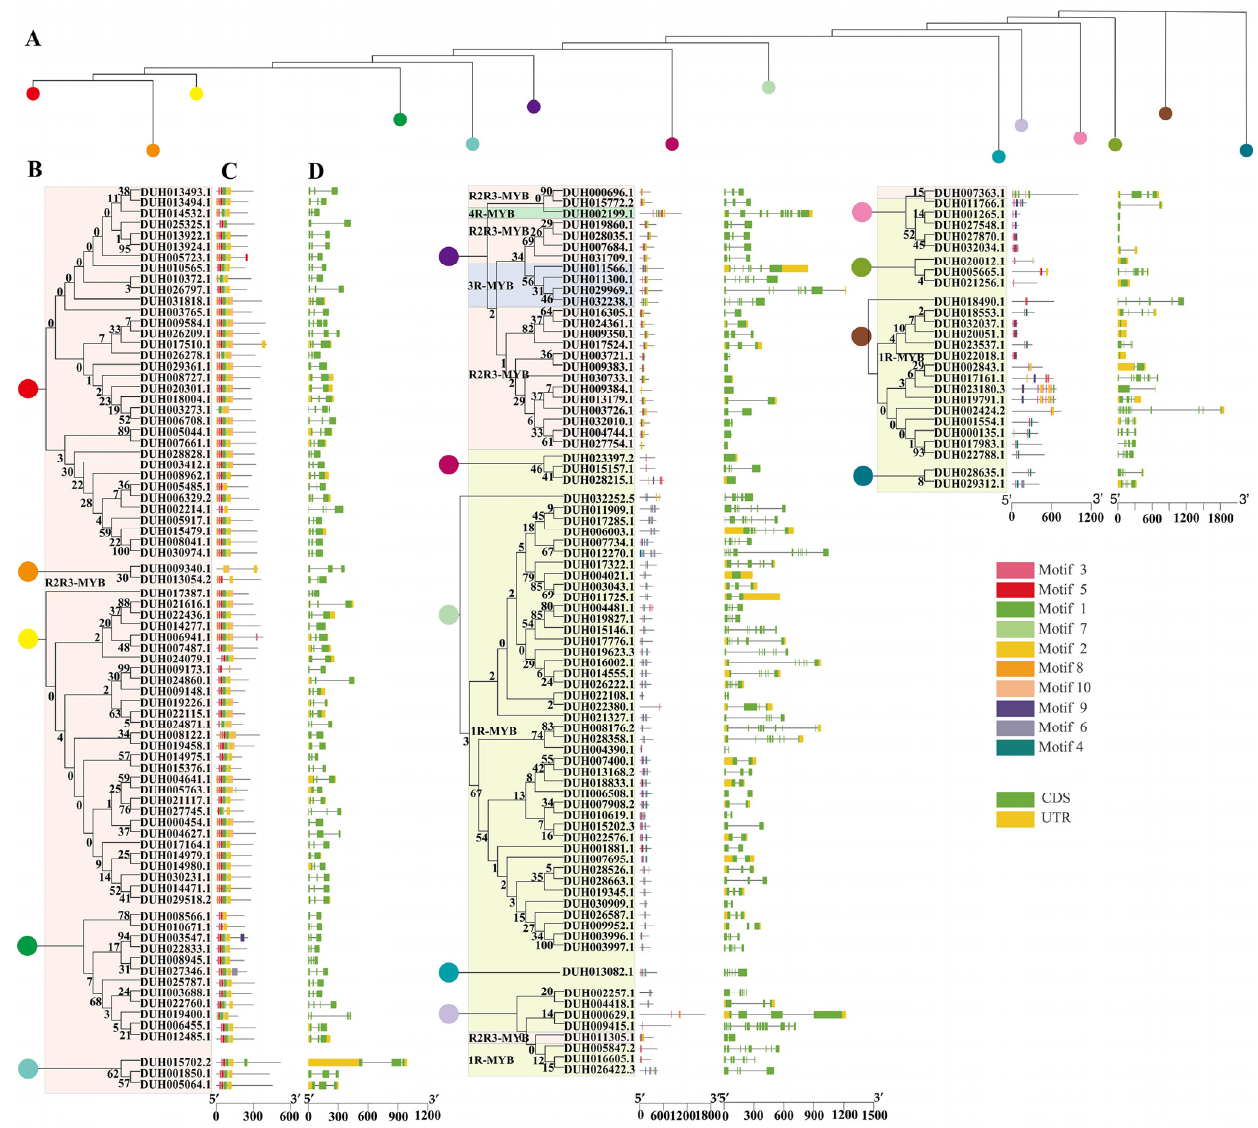
Figure 3 . Motif composition and gene structure of Rhododendron delavayi MYB genes. ( A ) Phylogenetic tree trunk of 184 R. delavayi MYB genes. Different colored circles indicate each node of the phylogenetic tree. ( B ) The MYB structural domains on each node branch were divided and marked with colored backgrounds. ( C ) Conservation motifs of the MYB proteins. Each motif represents a number in the colored box, and a black line represents the non-conserved sequence. ( D ) Gene structure of MYB. Green, yellow, and black colors represent the UTR, exon, and intron, respectively. The scale bar at the bottom indicates the length of motifs and genes, respectively.